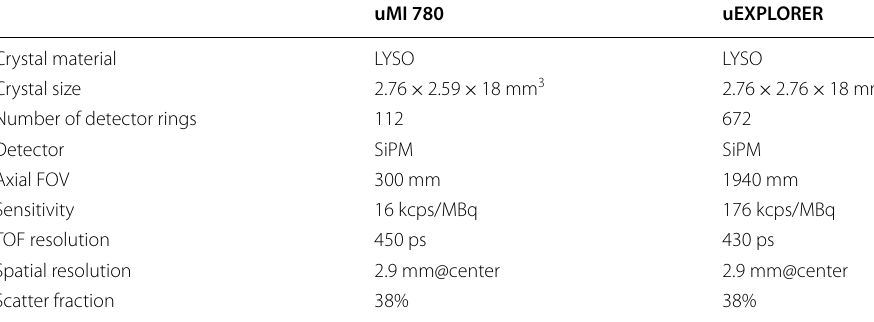
Table 2 PET scanner characteristics of uMI 780 and